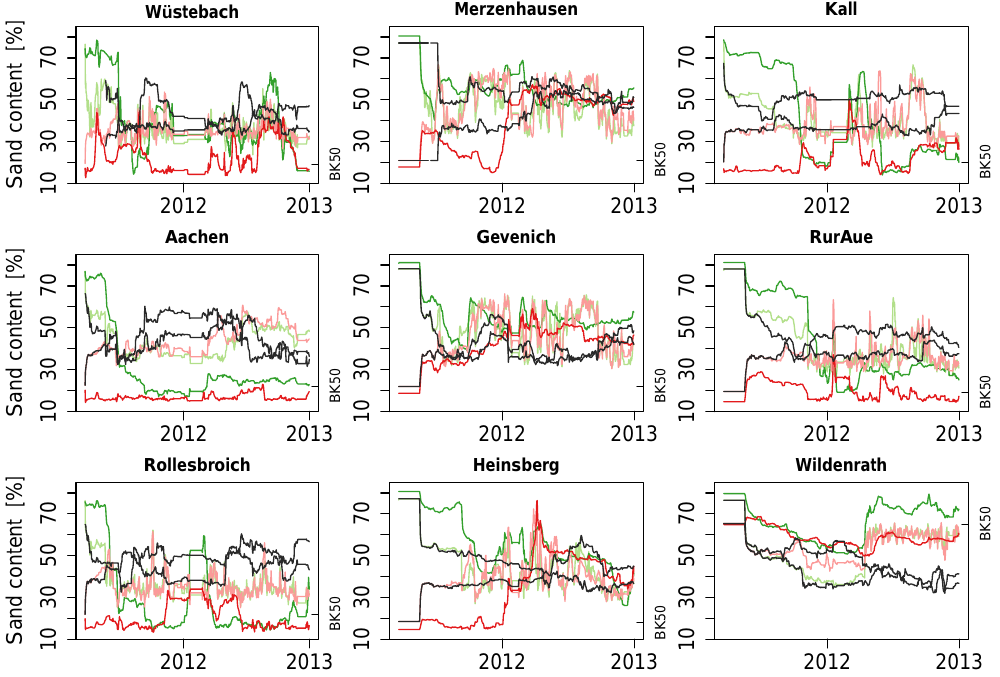
Figure 5. At nine sites, estimates of percentage sand content are shown for simulations with parameter update: PAR-S80-30 (green), PAR- S80-10 (light green), PAR-BK50-30 (red), PAR-BK50-10 (light red), jk8-S80- ∗ (black) and jk8-BK50- ∗ (black). The value of the BK50 soil map is marked at the second y axis.